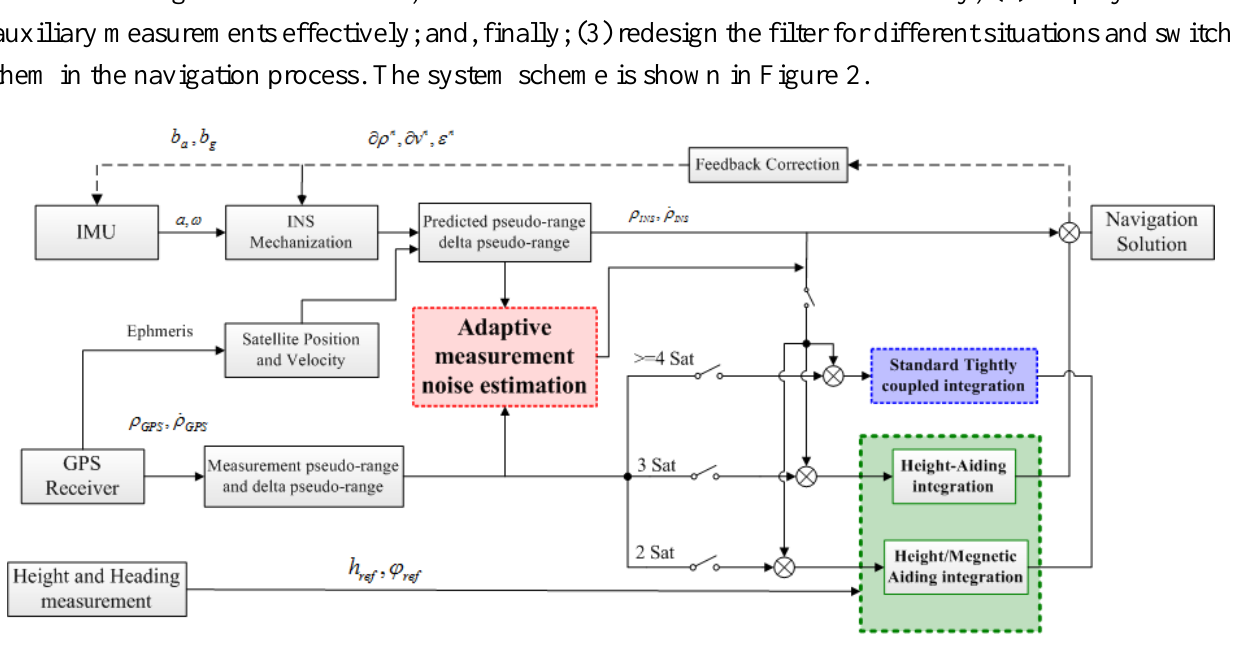
Figure 2. Adaptive tightly-coupled aiding (ATCA) system